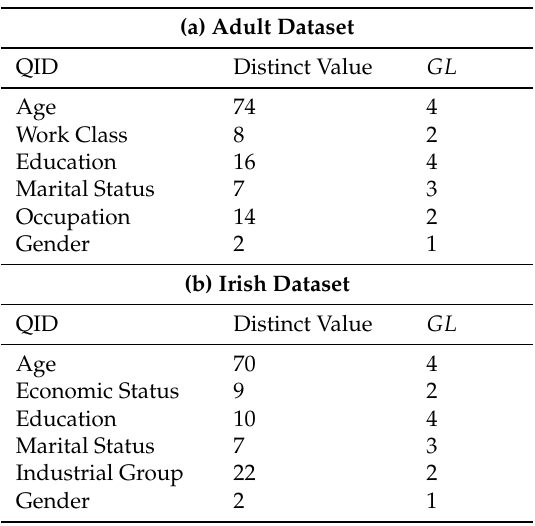
Table 3. Datasets.